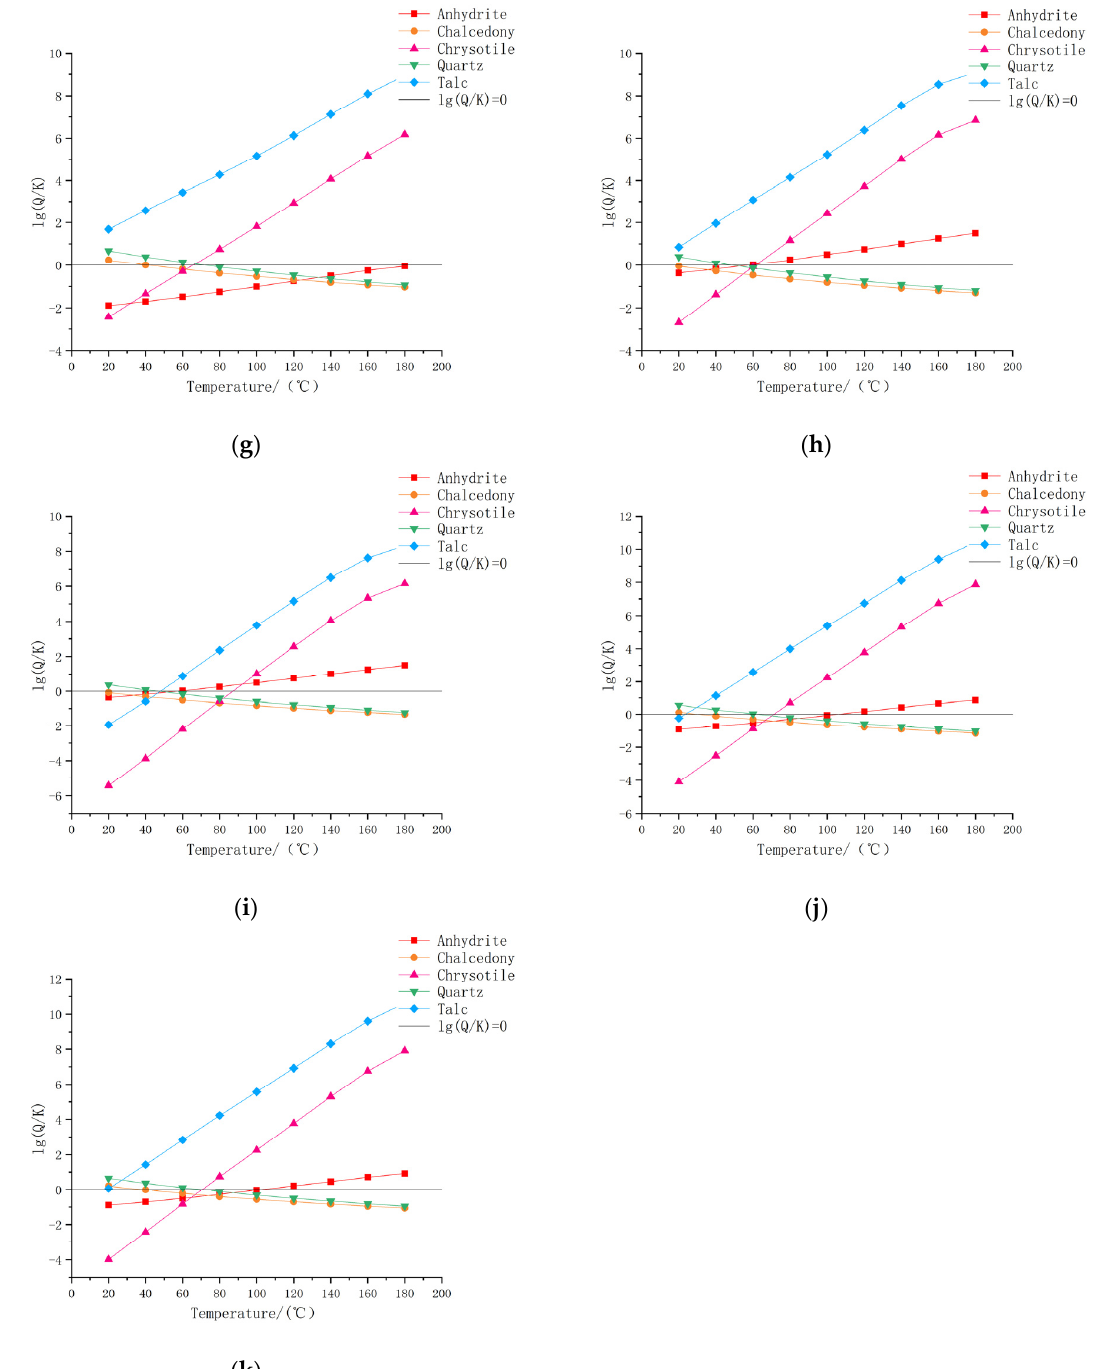
Figure 5. Mineral saturation diagram: ( a ) DXR-1; ( b ) DXR-2; ( c ) DXR-3; ( d ) DXR-4; ( e ) DXR-5; ( f ) DXR-6; ( g ) DXR-7; ( h ) DXR-8; ( i ) DXR-9; ( j ) DXR-10; ( k ) DXR-11.